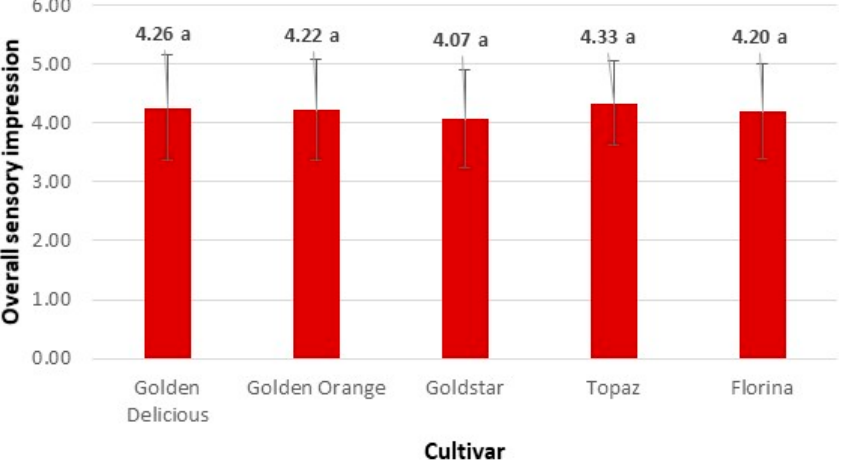
Figure 1. Mean value of overall sensory impression of the evaluated apple cultivars. The letter ‘a’ indicate that there is no statistically significant differences between cultivars at p ≤ 0.05.